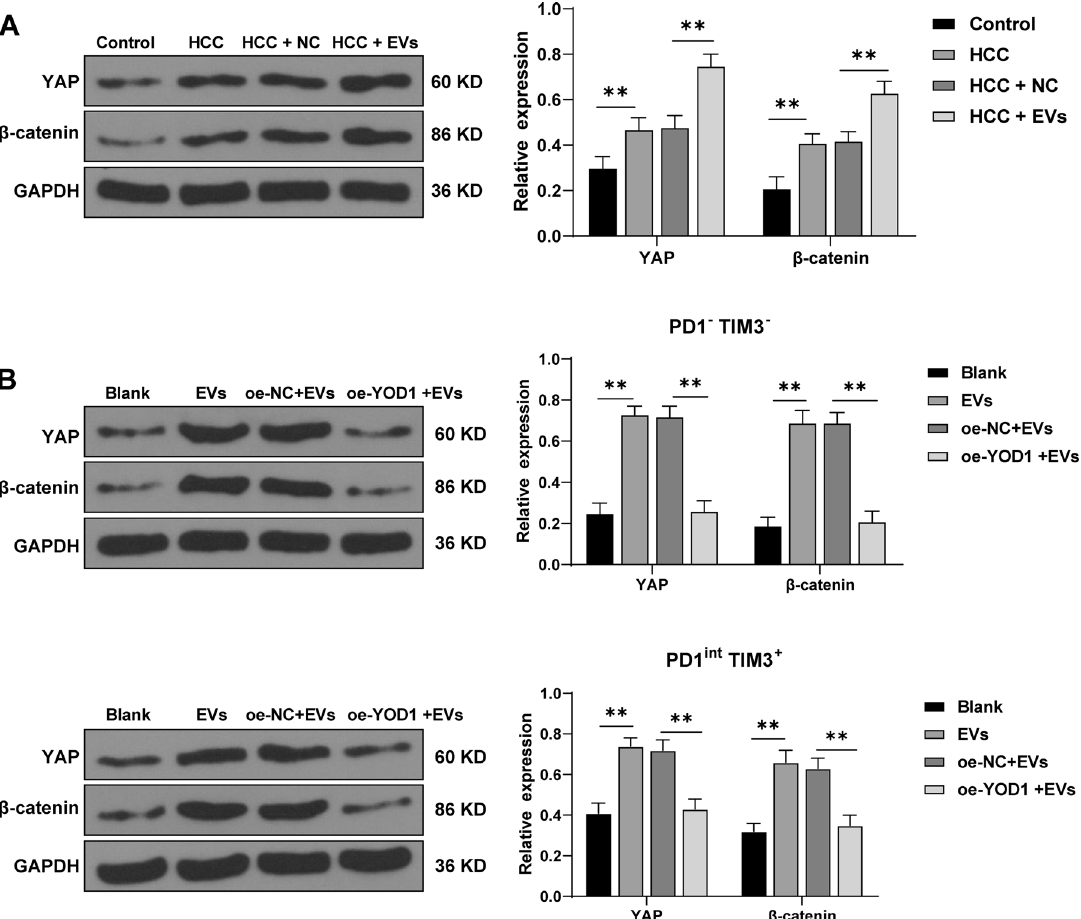
Fig. 7 YOD1 inhibited the YAP/ β -catenin pathway. A , B The levels of YAP and β -catenin in HCC mouse liver and PD1 - TIM3 - and PD1 int TIM3 + cells were detected using Western blotting. N = 6. The cell experiment was repeated 3 times. Data are presented as mean ± standard deviation and analyzed using one-way ANOVA, followed by Tukey ’ s multiple comparison test, ** p < 0.01.